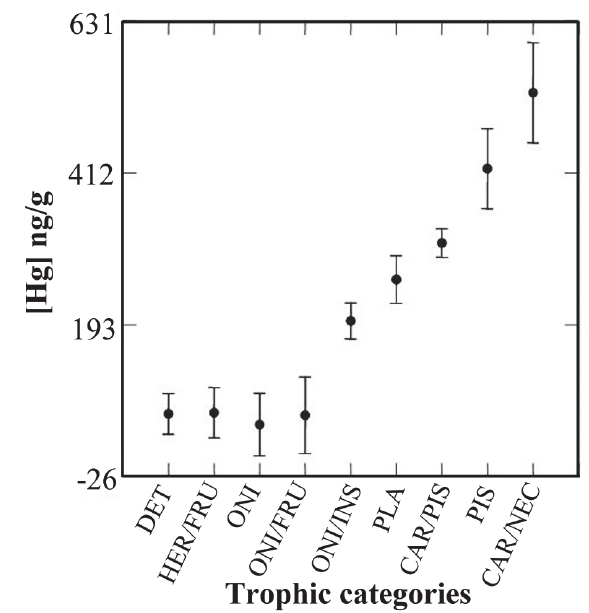
Fig. 2. Mean levels of total mercury in fish from different